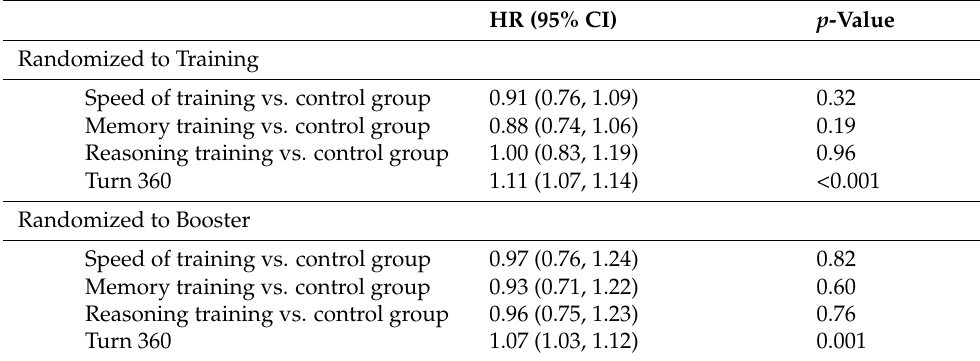
Table 2. ITT Cox regression results for future falls among the full